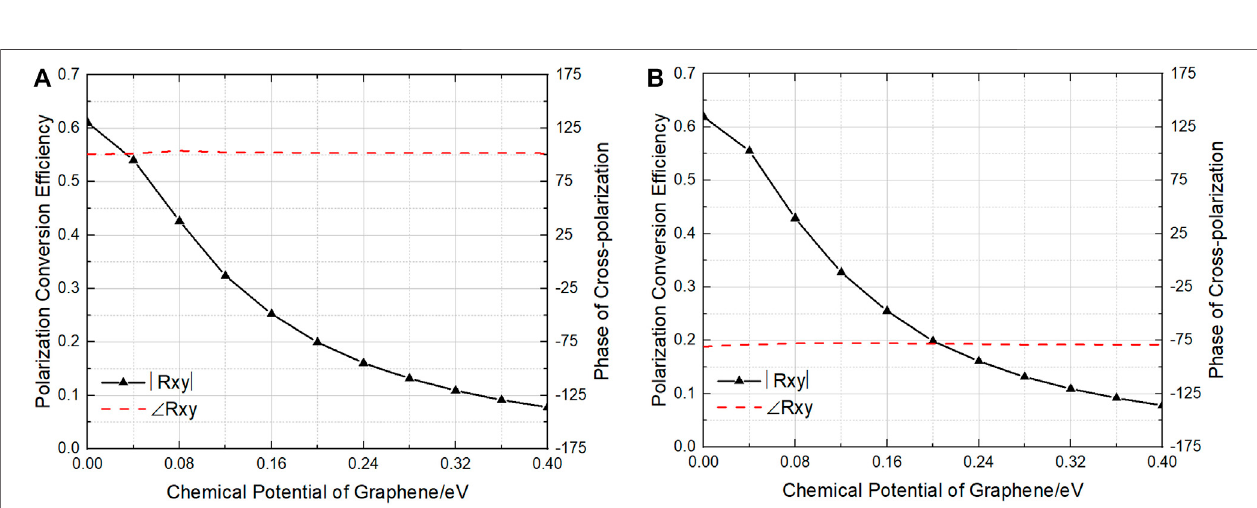
FIGURE 2 | (A) The simulated conversion ef fi ciency and phase of left sub-atom. (B) The simulated conversion ef fi ciency and phase of right sub-atom.